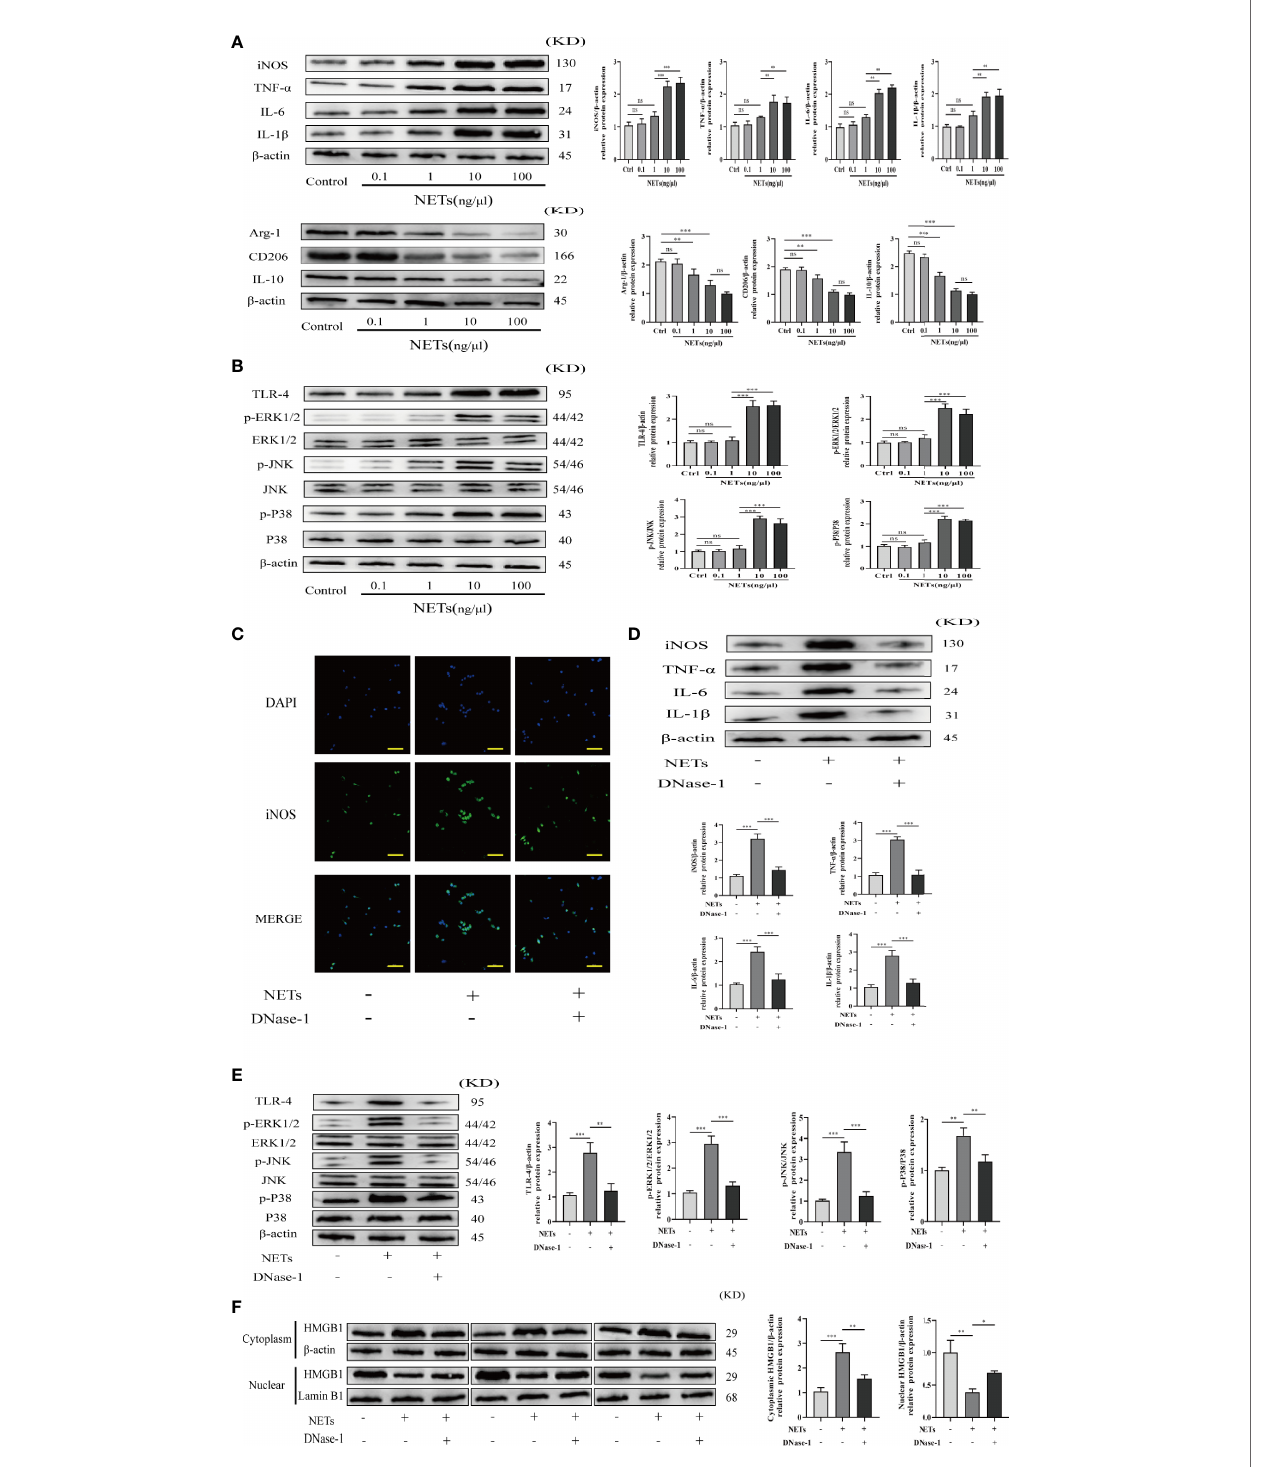
FIGURE 8 | NETs promote M1 polarization of Kupffer cells and HMGB1 intracellular translocation. (A, B) Expression of M1/M2 polarization markers and TLR-4/MAPK signaling pathway factors in Kupffer cells induced by different concentrations of NETs. (C) Immuno fl uorescence assessment of Kupffer cell M1 polarization as determined by iNOS colocalization and DAPI (magni fi cation, ×400; scale bar = 50 m m). (D, E) Expression of M1 polarization markers and TLR-4/MAPK signaling pathway factors in Kupffer cells stimulated by NETs in the absence or presence of DNase-1. (F) Immunoblotting was used to determine the translocation of HMGB1 from the nucleus to the cytoplasm. n = 6. One-way ANOVA was used to determine the statistical differences between groups. ns P < 0.05, * P < 0.05, ** P < 0.01, *** P <